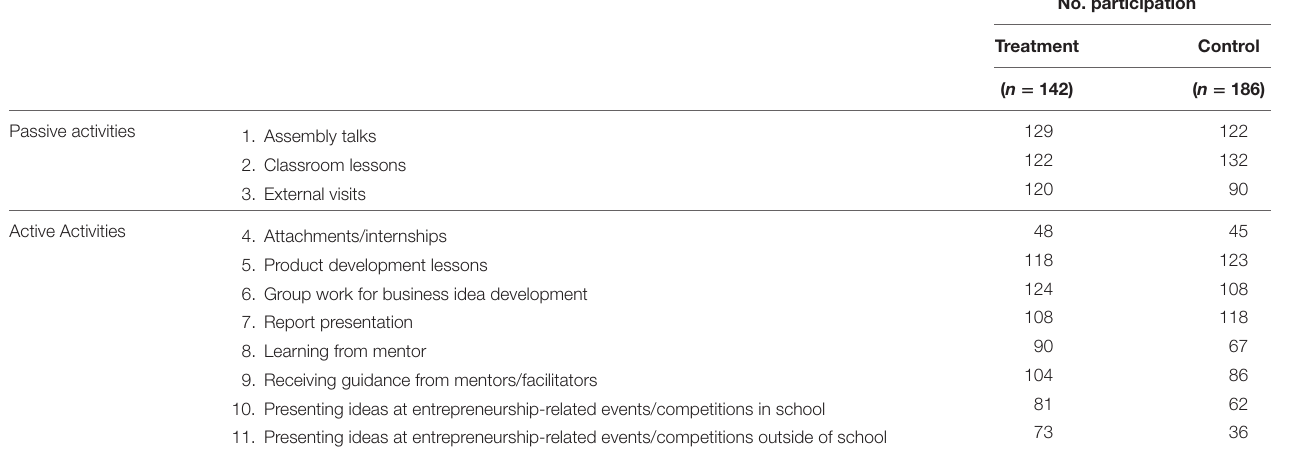
Table 1 | Frequency distribution of the participation in active and passive activities at Time 2.